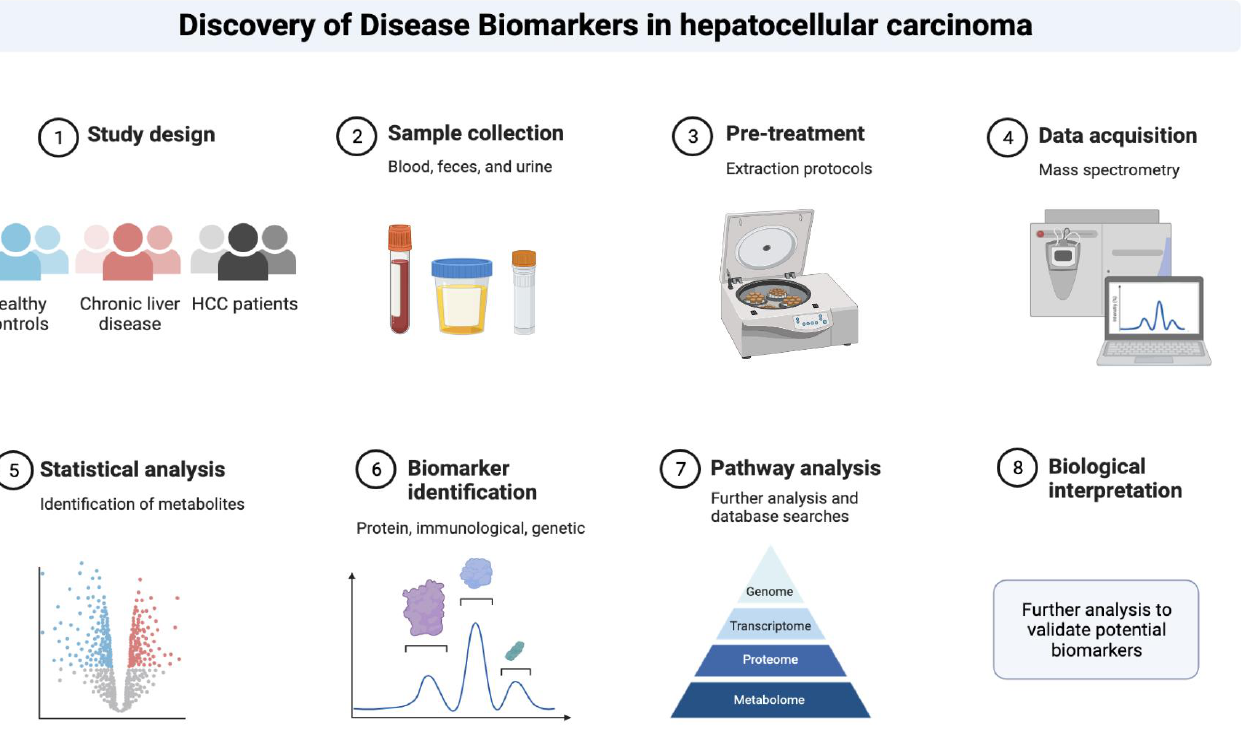
Figure 2. Depiction of the phases that could be taken to discover novel biomarkers in the context of hepatocellular carcinoma.